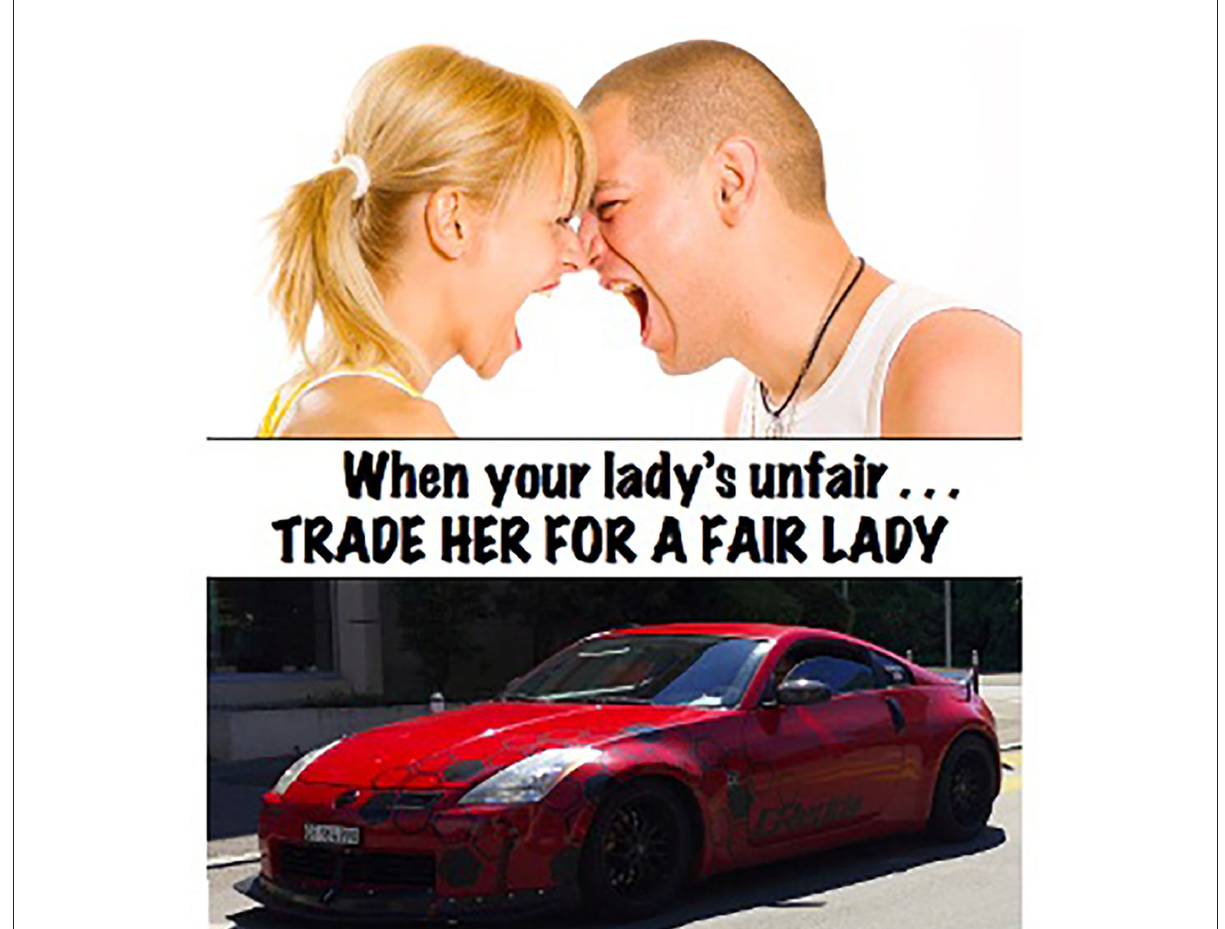
FIGURE2 Trade her for a fair lady. Photo credits for meme: Vic on Flickr: couple arguing: https://creativecommons.org/licenses/by/2.0/; https://www. flickr.com/photos/59632563@N04/6238711264; Crash71100 on Flickr: Nissan 350Z: https://creativecommons.org/publicdomain/zero/1.0/; https://www.flickr.com/photos/152930510@N02/51247645444/in/photolist-2m5zzxS-UWj2Jb-2n8xZE7-2neWCj6-4QP6pt-MVwYLu- RsN3Y6-2gvNLqF-2nfTboQ-6B2ae9-2naKuY9-6fLtQp-2mVy5qs-2gwqBSm-2jsAaqs-QKm51R-2jcDhWF-Y5bGX5-2jbR1aL-2gK89MA-